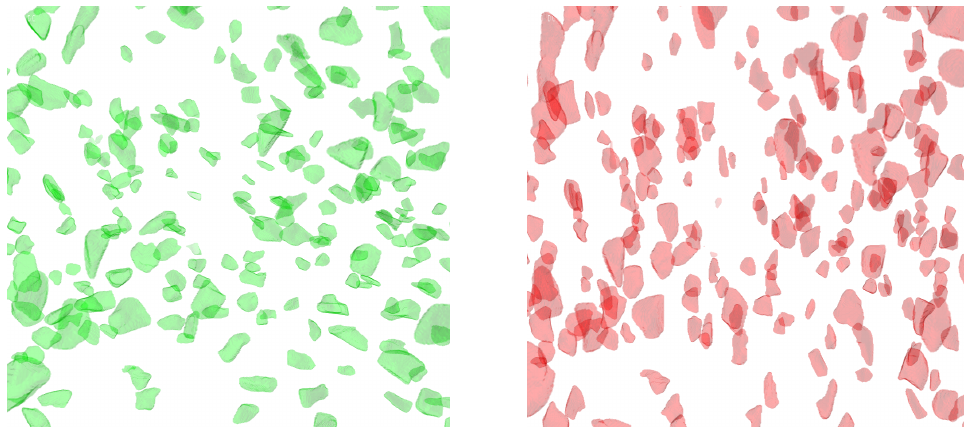
Figure 2. Central cuts of the tomograms of a gel with w s = 10% and c NaCl = 0molL − 1 at B = 0mT ( green ) and B = 380mT ( red